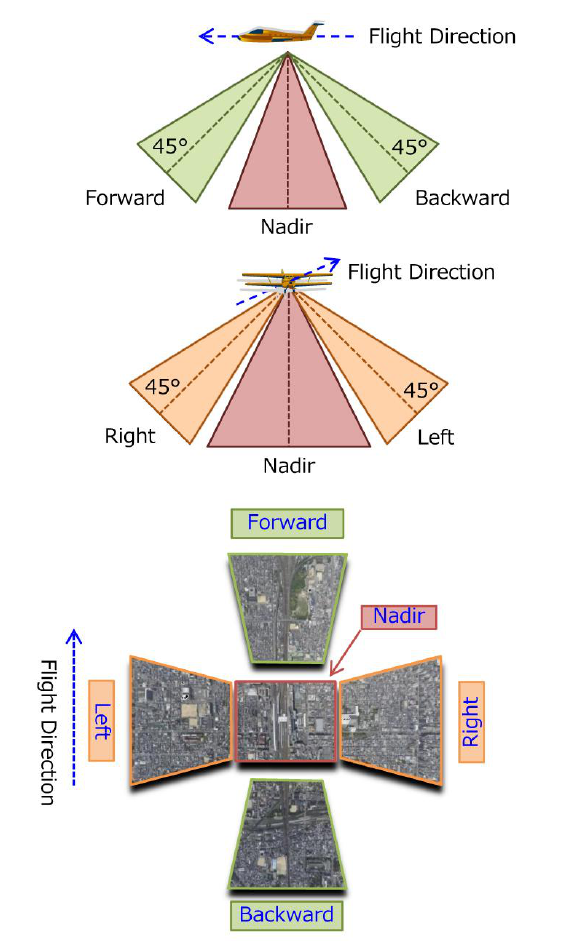
Figure 3. Concept of photography with PDC